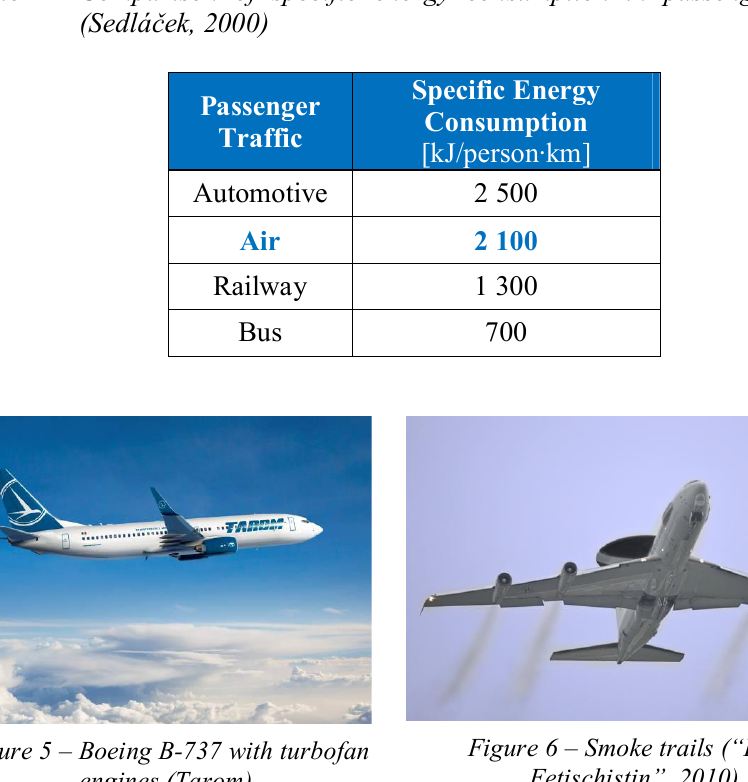
Table 1 – Comparison of specific energy consumption in passenger traffic